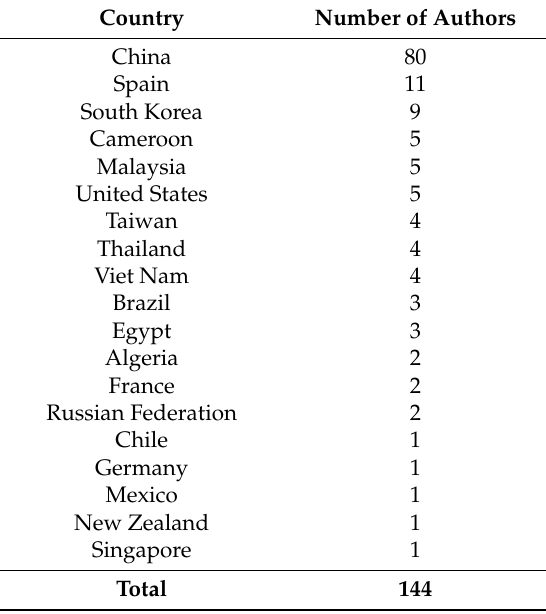
Table 1. Geographic distribution by countries of authors.